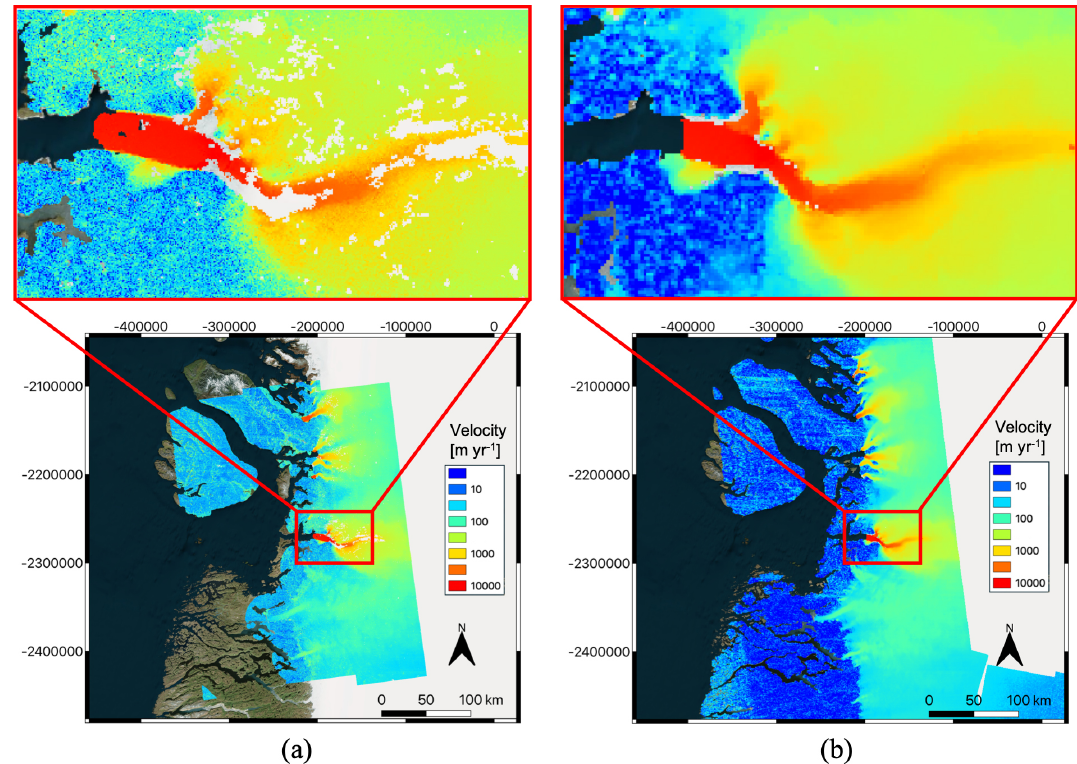
Figure 12. Comparison of (a) a single 120m posting 6d ITS_LIVE Sentinel-1 image pair (acquired on 20170404–20170410) to (b) the PROMICE 500m posting 24d averaged (20170323–20170416) product (b) for Jakobshavn Isbræ Glacier in Greenland. Background: © Mi- crosoft Bing Maps 2022.